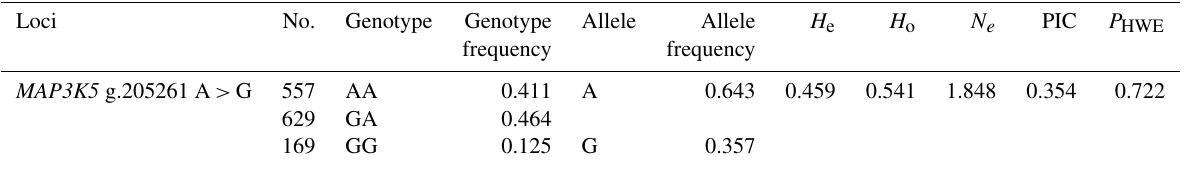
Table 3. Genetic parameters of SNP at the MAP3K5 loci. Loci No.